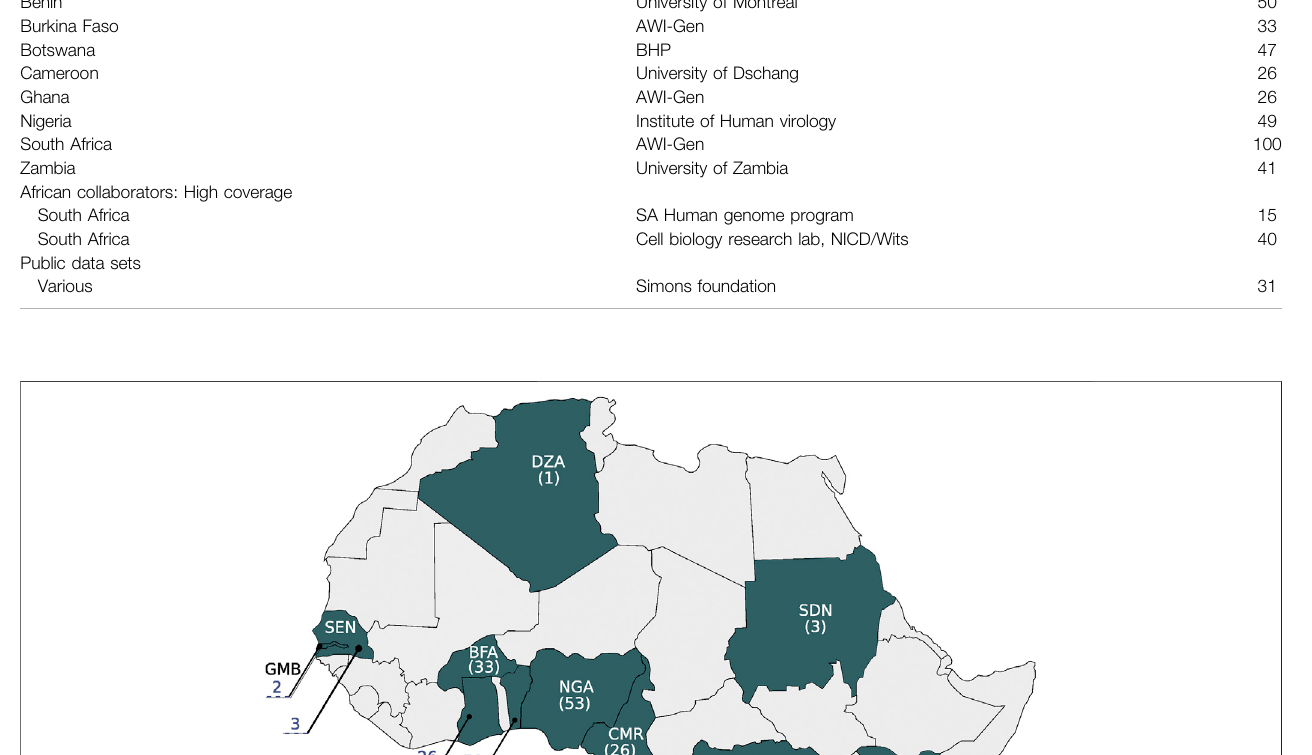
Table 1 and Figure 1 . The population structure of participants in this study is broadly representative of speakers of Niger-Congo languages from West through South Africa. Representation from